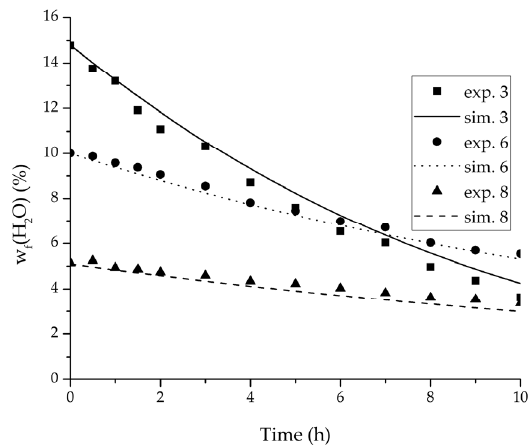
Figure 8. Experimental water mass fractions (feed) over time for three experiments used for the validation of the permeance function for ethanol/water compared with the corresponding simulation result.